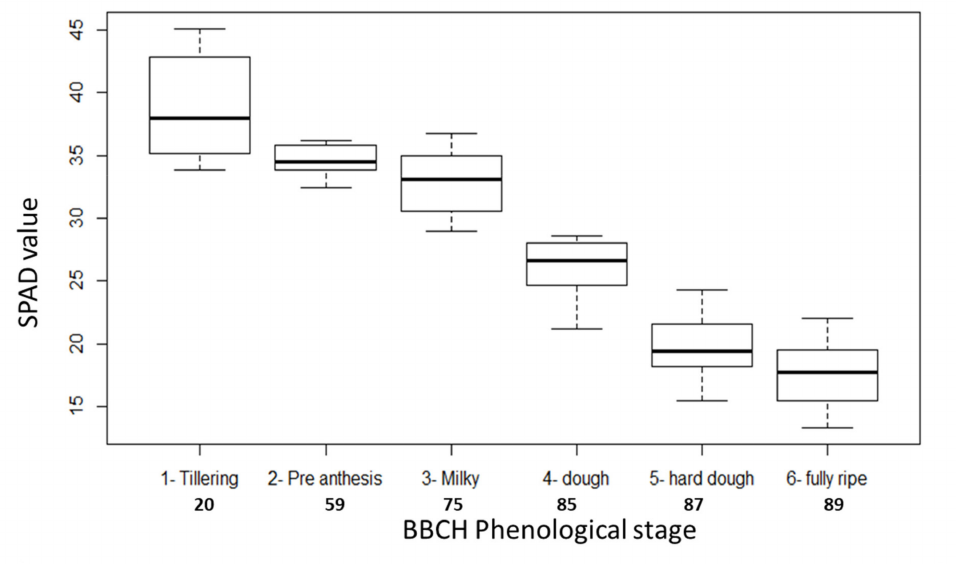
Figure 5. SPAD measurement on proso millet during the 2020 life cycle at the VM site. SPAD values drop throughout the life cycle, from 38.9 during BBCH principal stage 2 (tillering, contemporary in millet to stem elongation-BBCH principal stage 3, see Ventura et al., 2020) to 17.6 at BBCH 89 (full maturity), in accordance with crop progressive senes- cence as the life cycle is completed. Figure 6 shows the good accordance of 2019, 2020, and 2021 SPAD values for the main phenological stages. Therefore, in all experimentation years, millet SPAD values stayed high until flowering, indicating optimal crop vigor, without any clue of drought stress, and then dropped in the last phenological stages, in line with a normal drop in physiological parameters associated with crop senescence [30].